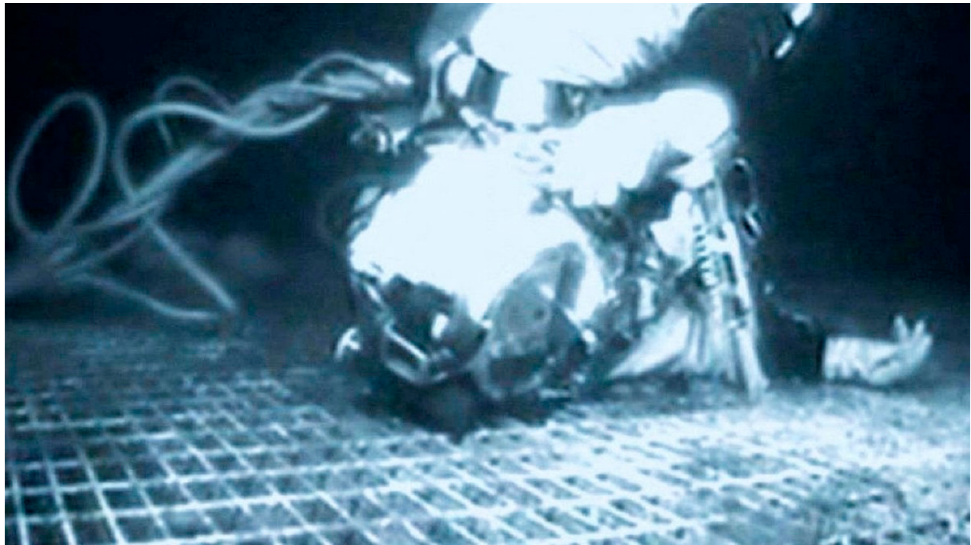
Figure 4. The remotely operating vehicle (ROV) finds Dc on top of the steel construction. Reprinted with permission from [6]. Copyright 2014 Floating Harbour.